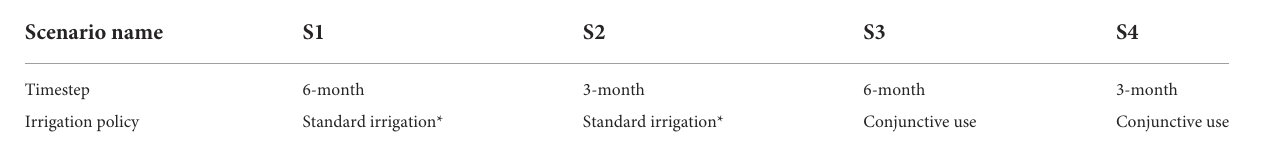
TABLE 2 Scenario